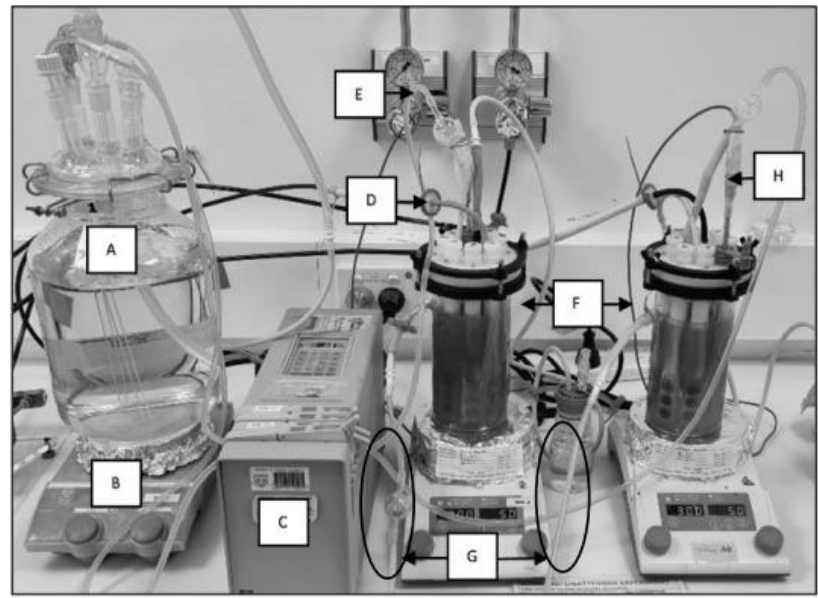
Figure 1. CDC reactor experimental set-up: ( A ) feeding cell with fresh reactor solution, ( B ) hot plate set to 30 °C and 50 rpm for CDC reactor, ( C ) pump for continuous flow replacing reactor solution by 30% weekly, ( D ) reactor gas inlet with 0.2 µm filter, ( E ) media inlet with air lock to prevent feeding cell contamination, ( F ) CDC reactor duplicate experiments, ( G ) reactor solution outlet for continuous flow (with air locks), and ( H ) thermocouple probe.